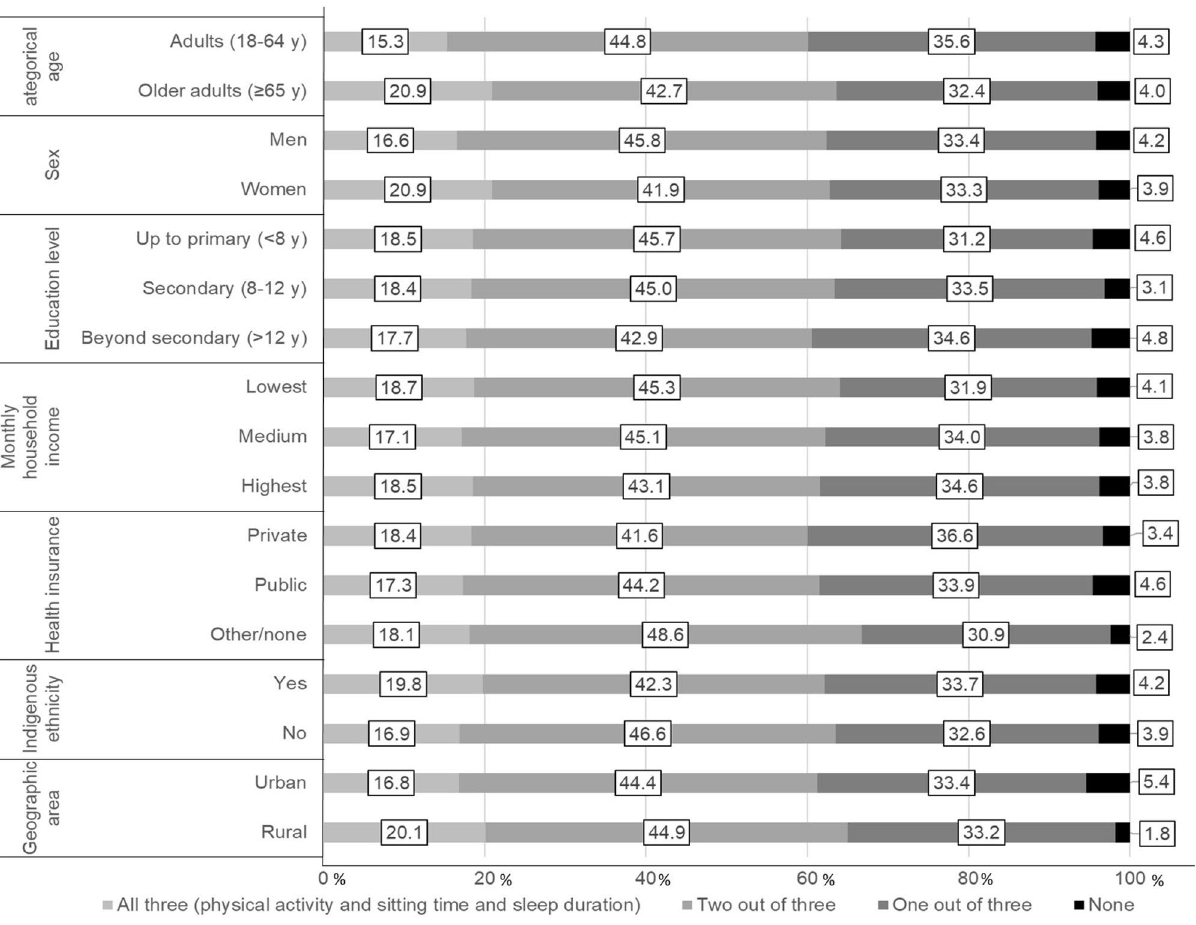
Figure 2. Proportion (%) of participants meeting the general combinations according sociodemographic